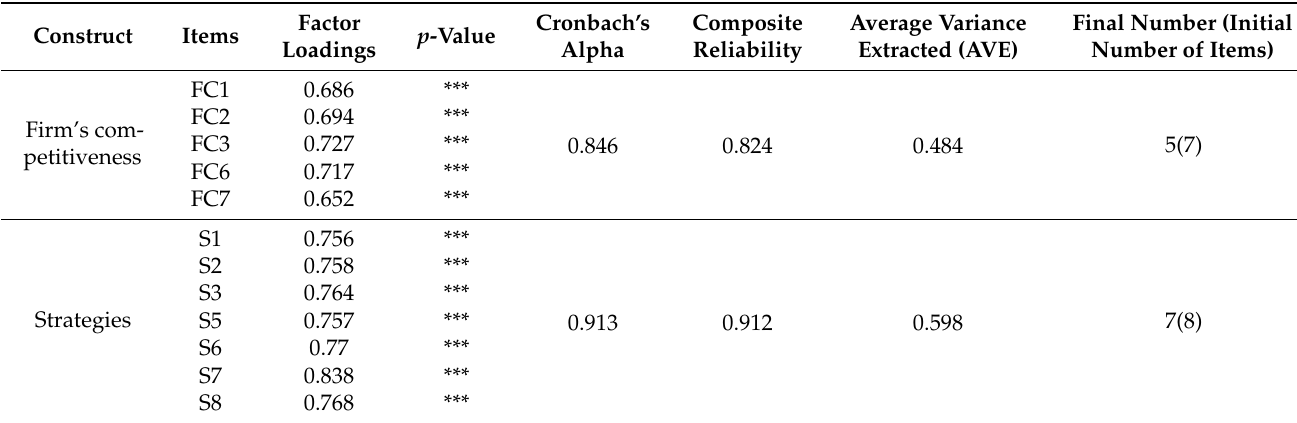
Table 9. Statistical evidence of reliability and convergent validity.